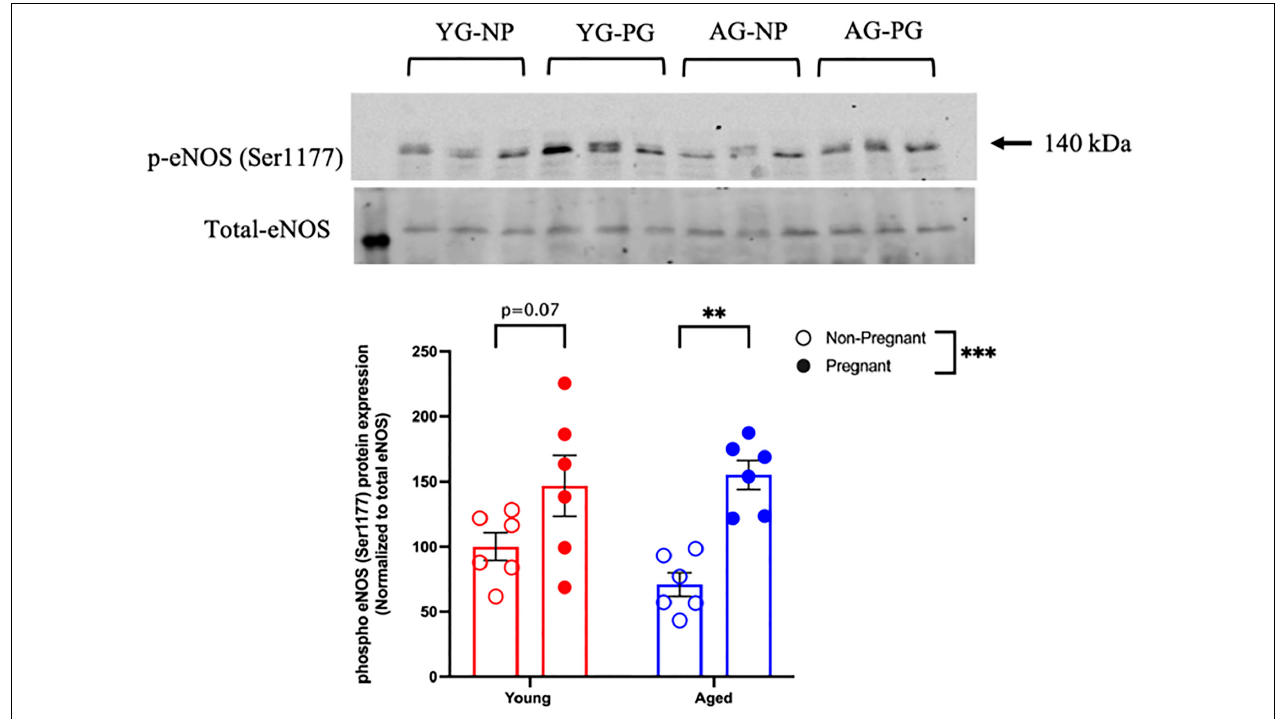
FIGURE 4 | Increased phosphorylation of eNOS protein in young and aged pregnant rats. Western blot analysis of phospho-eNOS (Ser1177) normalized to total eNOS in mesenteric arteries of young (3–4 months; in red) and aged (9–9.5 months; in blue) pregnant (on gestational day 20; closed circles) and non-pregnant (age-matched; open circles) rats. Data are presented as mean ± SEM and expressed as percentage of control (i.e., the mean of the non-pregnant young group); analyzed by two-way ANOVA with Sidak’s multiple comparisons post hoc test; ∗∗ p < 0.001; ∗∗∗ p < 0.001; n = 6/group. YG-NP, young non-pregnant; YG-PG, young pregnant; AG-NP, aged non-pregnant; AG-PG, aged pregnant.